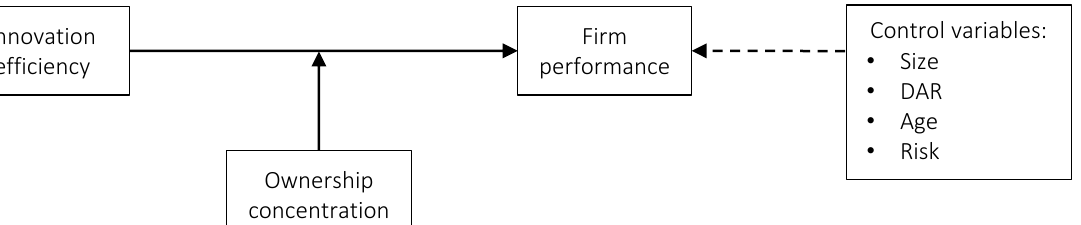
Figure 1. Conceptual framework